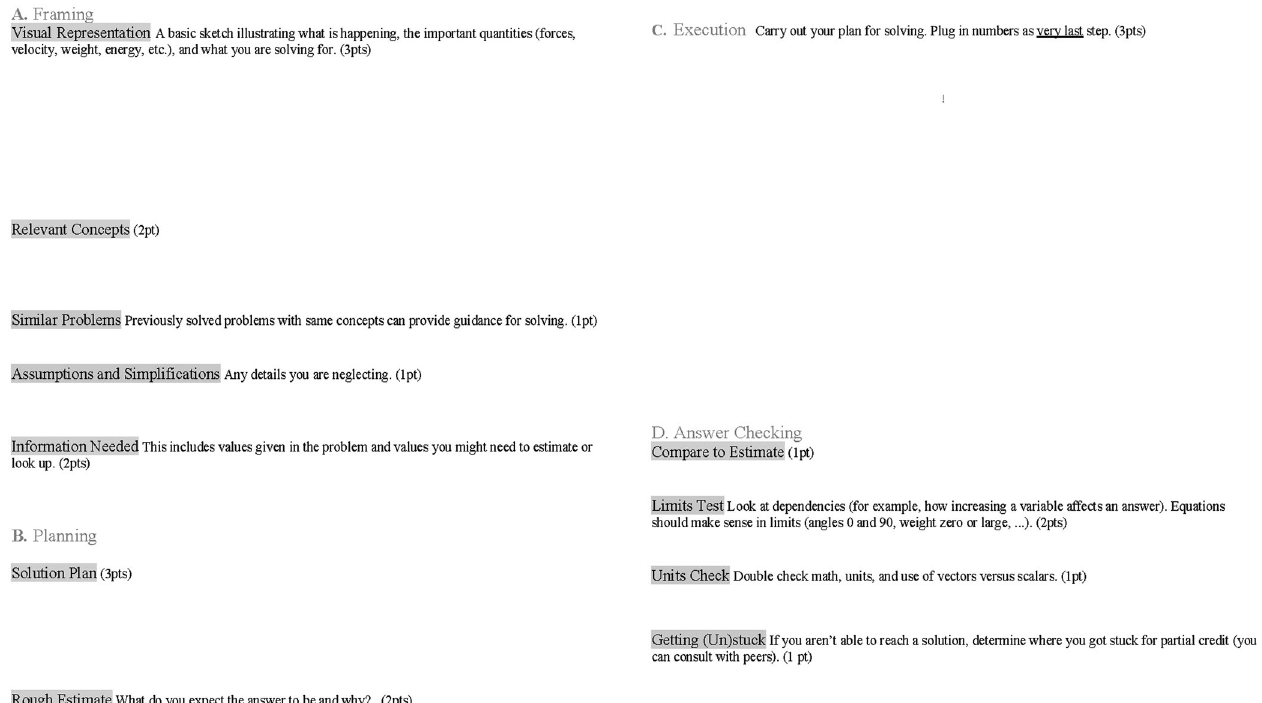
FIG. 1. Problem-solving